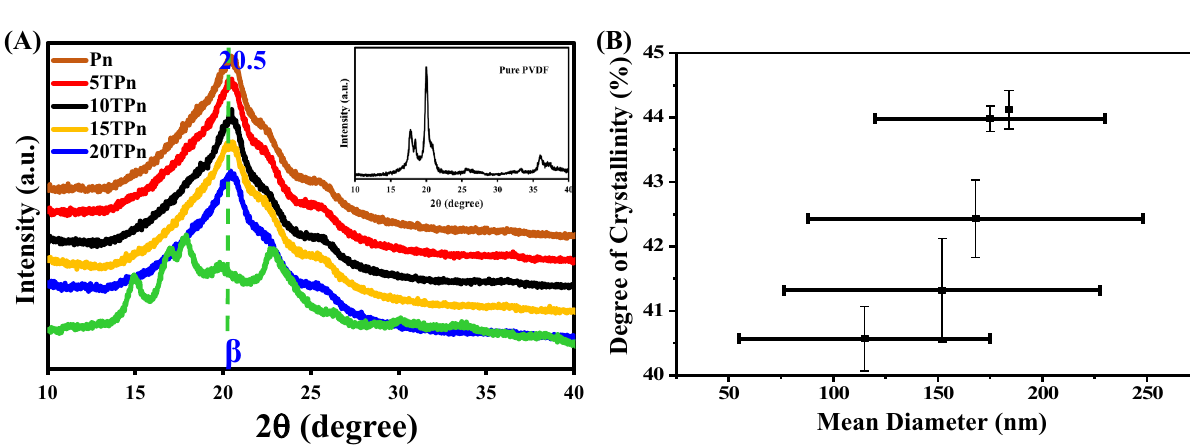
Figure 4. ( A ) XRD patterns and ( B ) Degree of crystallinity of PVDF, TPS, and PVDF/TPS